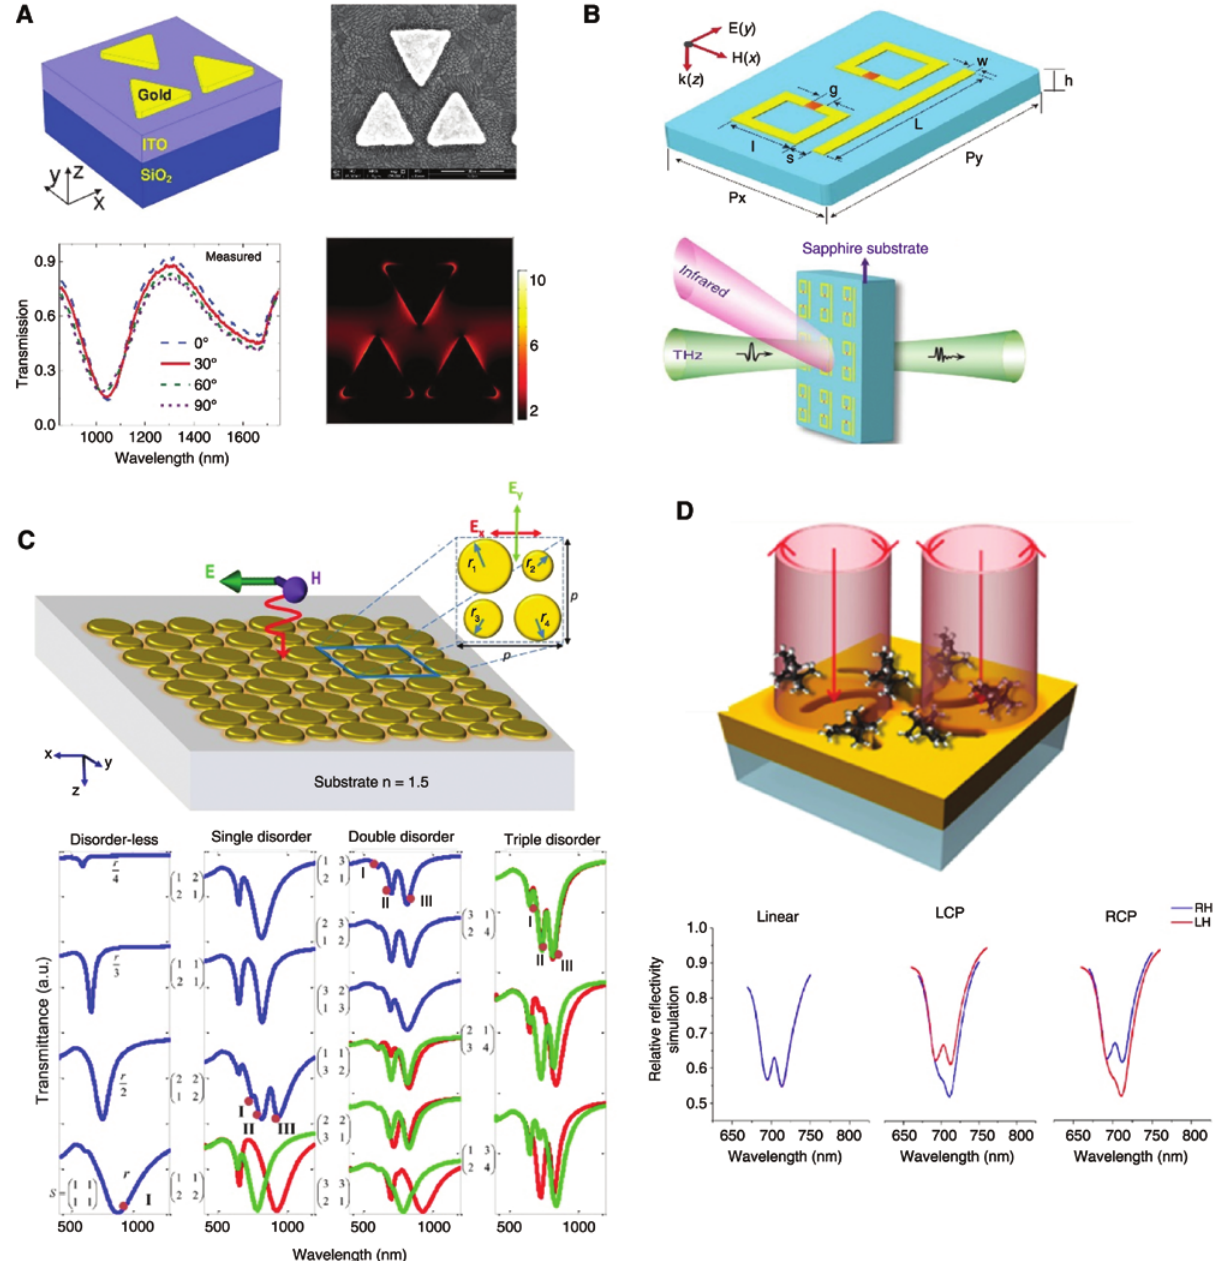
Figure 2: Schematic of typical out-of-plane coupling configurations for PIT structures. (A) Schematic and the SEM image of a polarization-insensitive PIT structures composed of gold triangle nanoprisms on ITO substrate. The measured transmission spectra indicate that the structure is insensitive to the incident light polarization states. The simulated field distributions at the transparent window is also provided [43]. (B) Active all-optical tunable PIT structures containing SRRs with silicon nanoislands embedded in the gaps. With IR pump excitations, the refractive index of silicon islands can be changed and the PIT effect at the THz range can be tuned [44]. (C) Plasmonic quasicrystal arrays with disordered gold nanodisks. The thickness of the PIT metasurface is 10 nm. The period of the unit cell is 266 nm. The unit cell consists of four gold nanodisks, each with different radii arranged in a square lattice. Tuning the radius of nanodisks can influence the disorder state of the structure, resulting in tuning the PIT response in the optical frequency range. The blue lines correspond to the polarization-independent case, whereas red/green lines correspond to x/y polarization cases, respectively [45]. (D) Chiral PIT structures with dichroic coupling mechanism. Reflectivity spectra for RH and LH shuriken nanostructures in water are also provided, including for linearly polarized input light, LCP input light, and RCP input [46]. (a) Reproduced with permission from Ref. [43]. Copyright 2014 Wiley. (b) Reproduced with permission from Ref. [44]. Copyright 2012 Macmillan Publishers. (c) Reproduced with permission from Ref. [45]. Copyright 2015 ACS. (d) Reproduced with permission from Ref. [46]. Copyright 2018